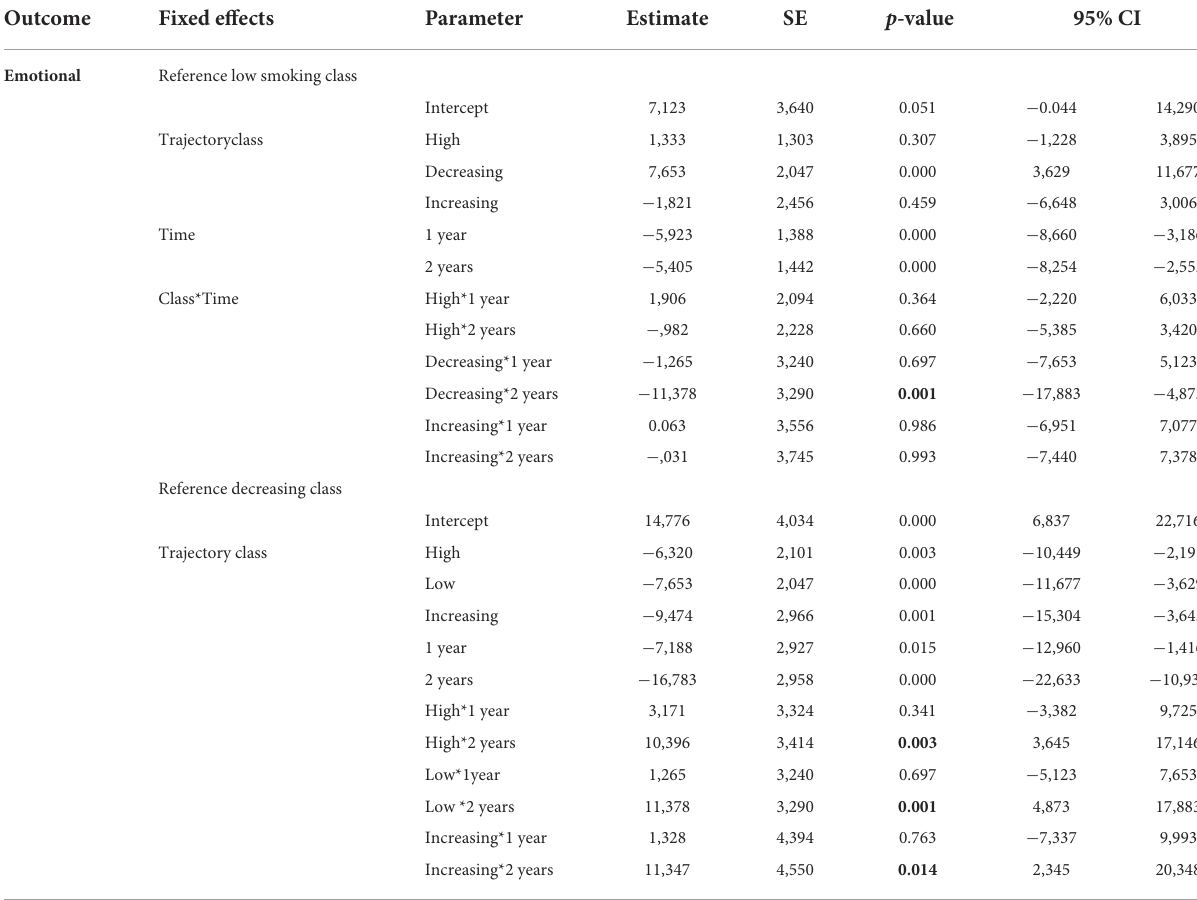
TABLE 4 Results of mixed model analyses of the effect of trajectory class membership on emotional disturbances.